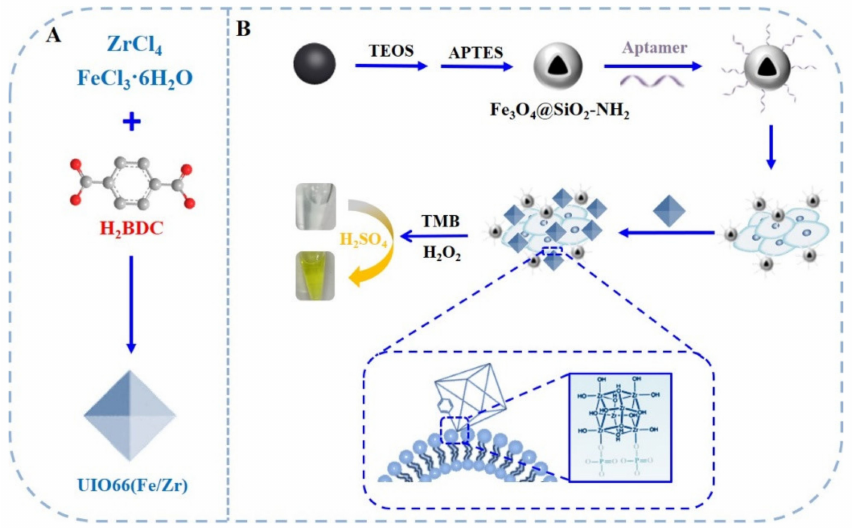
Figure 1. Schematic illustration of ( A ) UIO-66(Fe/Zr) synthesis and ( B ) their application in construct- ing a single aptamer-dependent sandwich-type biosensor for colorimetric detection of cancer